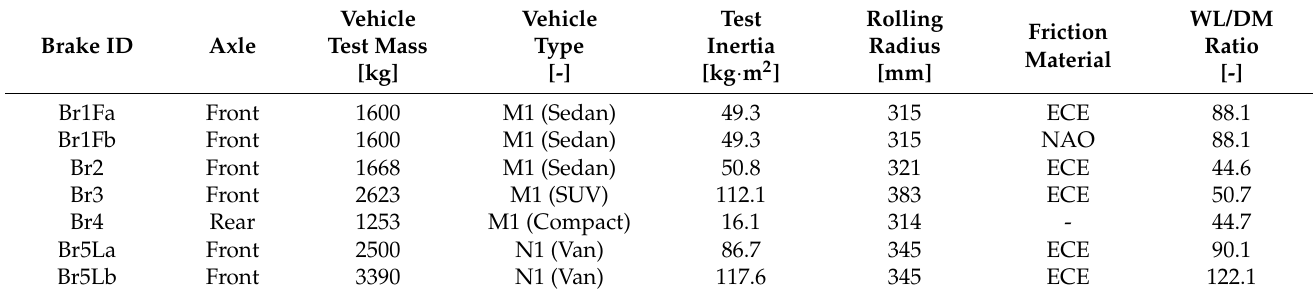
Table 1. Main characteristics of tested brakes. WL/DM = Wheel load/Disc mass. ECE refers